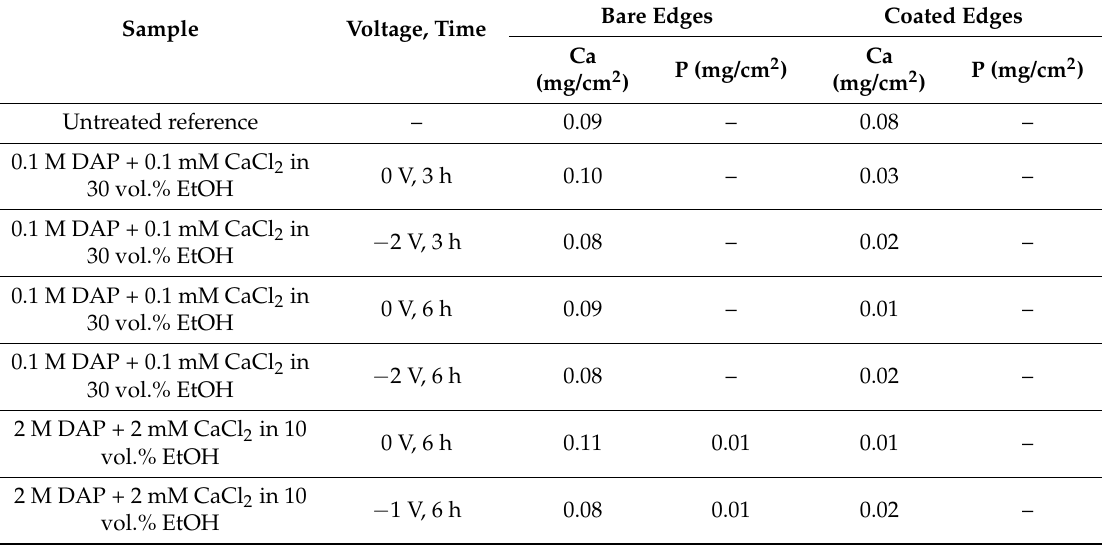
Table 1. Weight amounts of Ca and P per unit area of surface exposed to the acid attack, dissolved from untreated and treated marble samples, measured by inductively coupled plasma optical emission spectrometry (ICP) in the solutions collected at the end of the acid resistance tests (marble specimens with bare edges and coated edges were